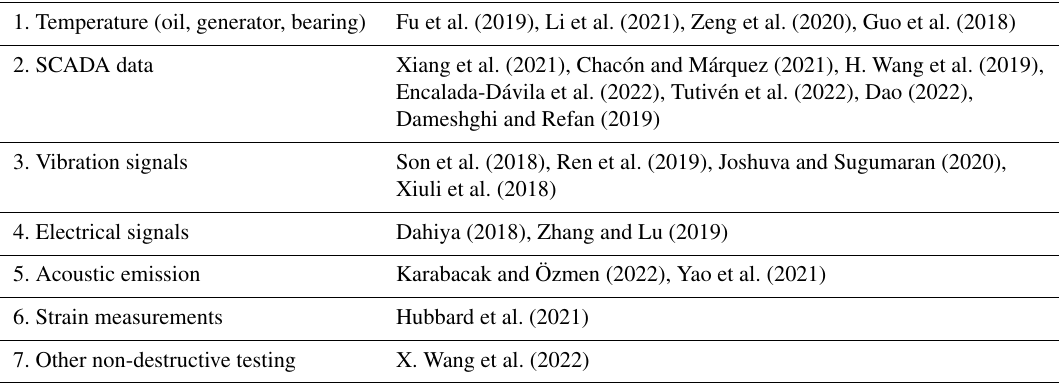
Table 2. Papers of investigations based on fault detection but classified according to the monitoring method used. 1. Temperature (oil, generator,